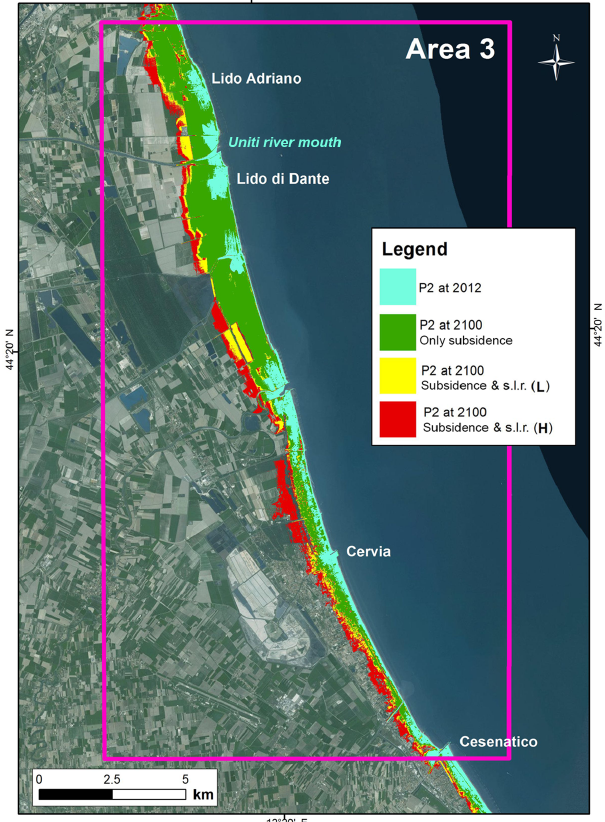
Figure 8. The same as in Fig. 6, but for Area